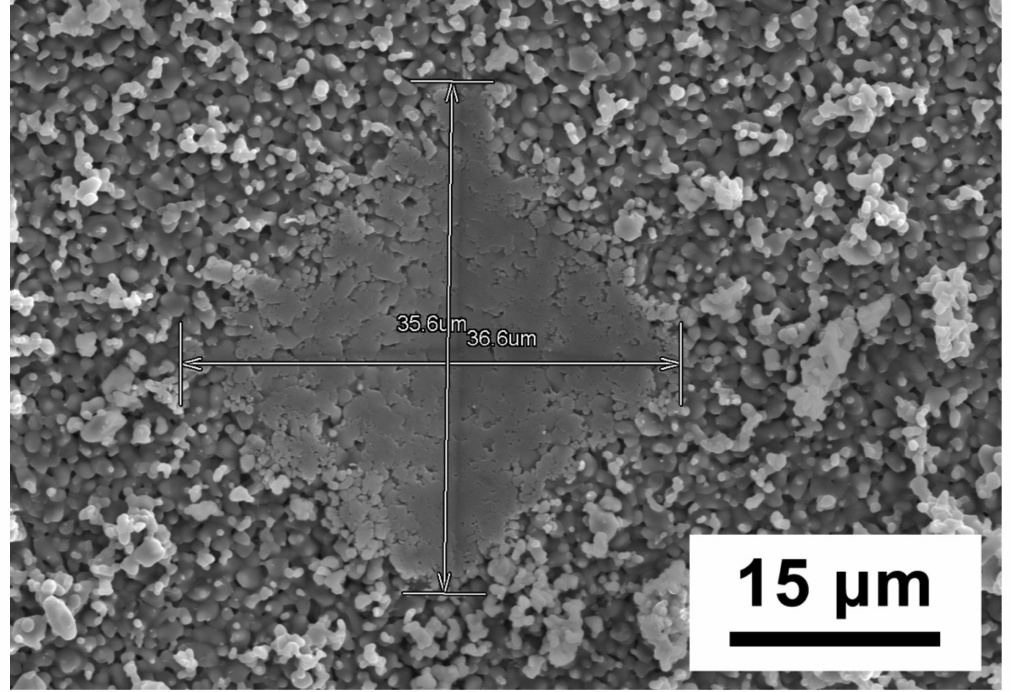
Figure 3. Vickers indentation size measurement from SEM